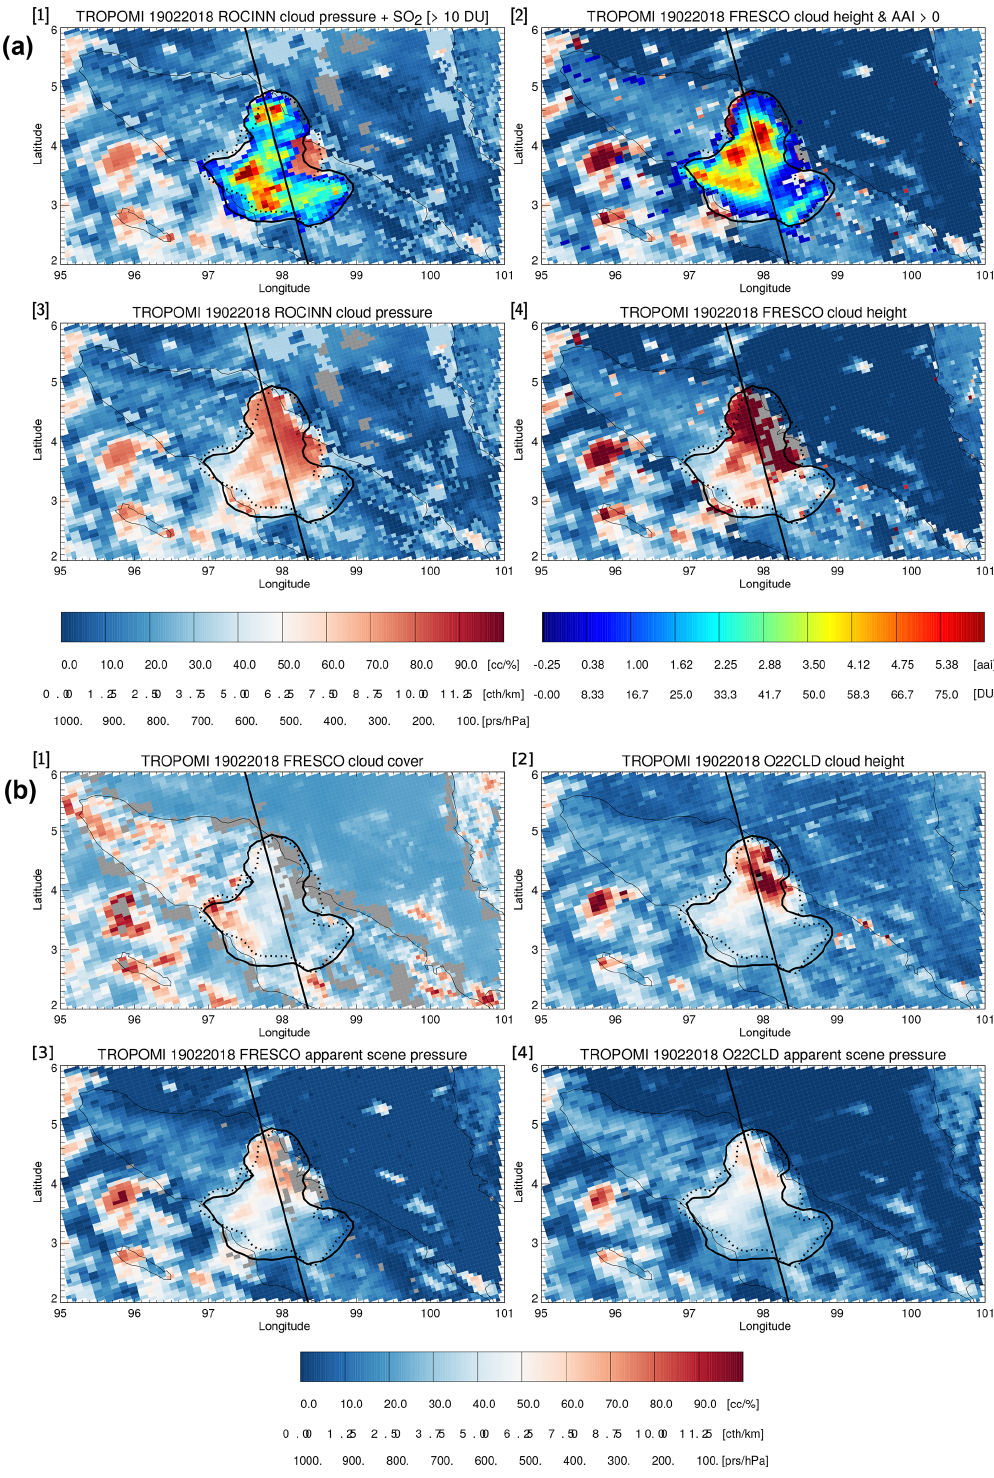
Figure 1. (a) TROPOMI cloud pressure (ROCINN; a1 and 3 ) and TROPOMI FRESCO cloud heights ( a2 and 4 ). TROPOMI SO 2 ( a1 ) and the AAI ( a2 ) for the overpass of the 19 February 2018 Sinabung eruption. The straight line denotes the path of the CALIPSO overpass, the solid-line shape denotes the outline of >10DU SO 2 columns, and the dotted-line shape denotes the AAI>0 value. Note that for FRESCO and ROCINN cloud heights certain pixels are greyed out (“no data”), related to yet-unresolved retrieval artifacts. (b) As in (a) but for TROPOMI FRESCO cloud cover ( b1 ), O22CLD cloud height ( b2 ), FRESCO apparent scene pressure ( b3 ), and O22CLD apparent scene pressure ( b4 ). cc is cloud cover, cth is cloud top height, and prs is cloud pressure and scene